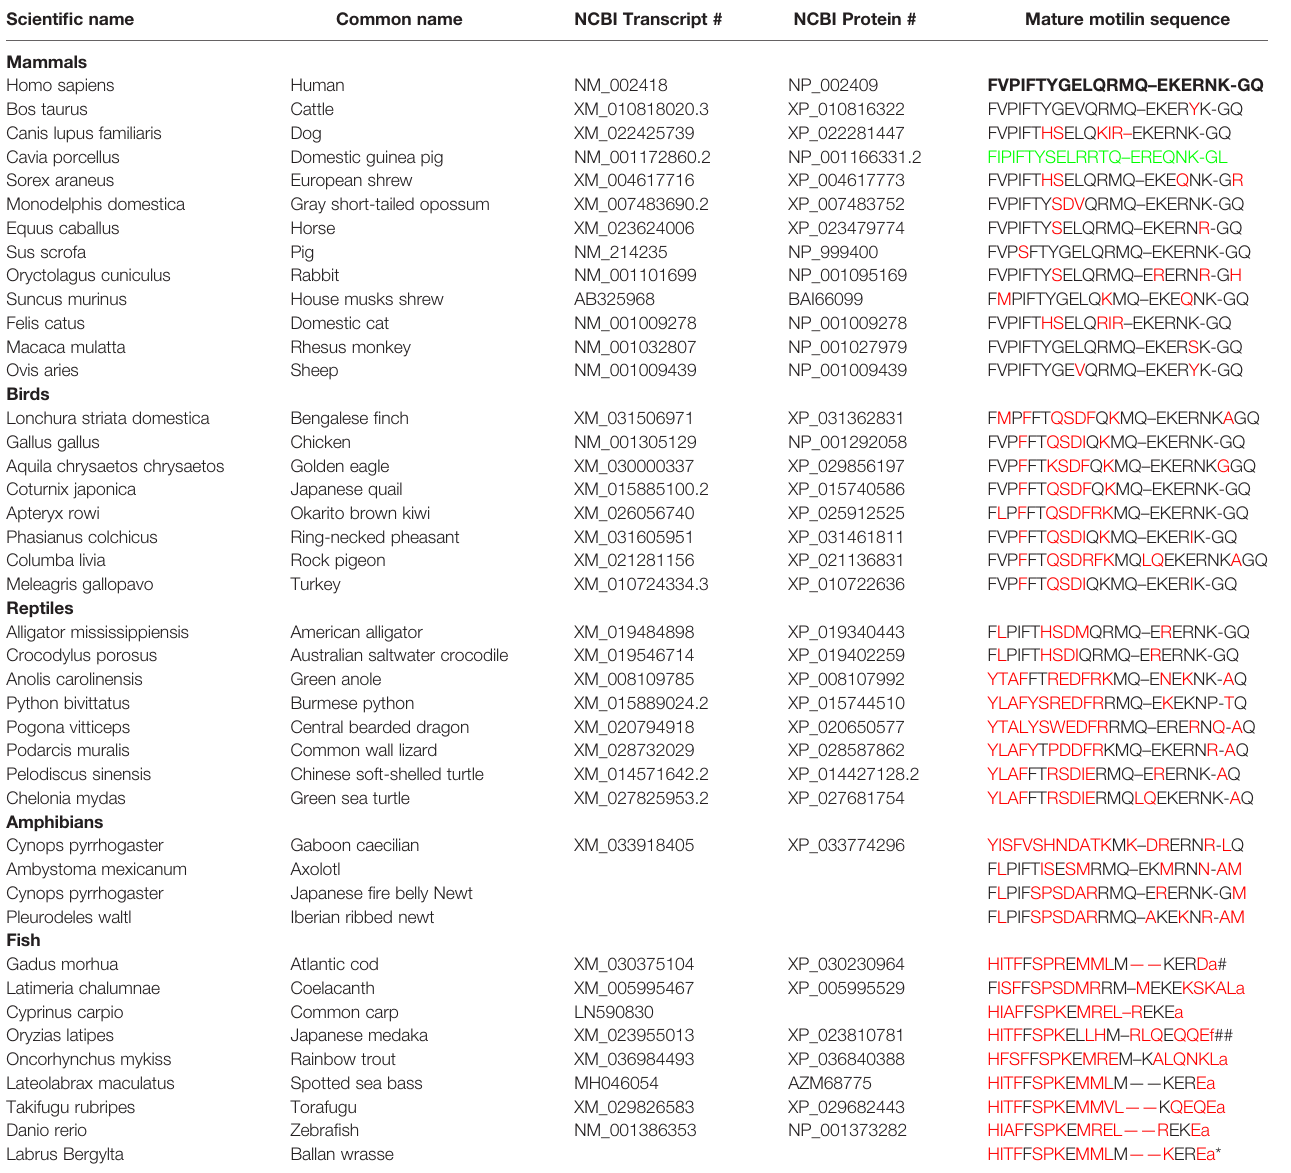
TABLE 1 | Representative information on motilin in various